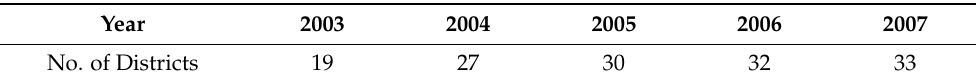
Table 5. Expansion of administrative territories (districts) harboring Dirofilaria-infected dogs, Moscow region, 2003–2007.